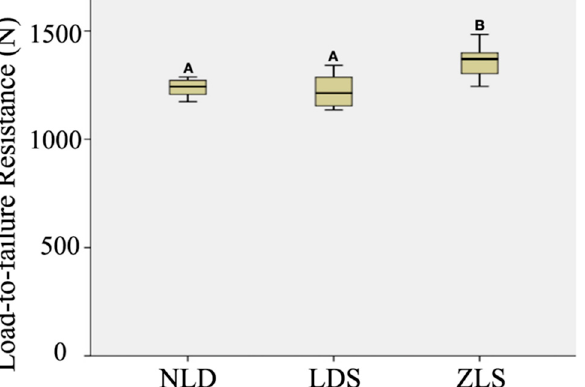
Figure 2. Box plot graph of load-to-failure resistance of all materials; different uppercase letters present significant differences among groups, p < 0.05.